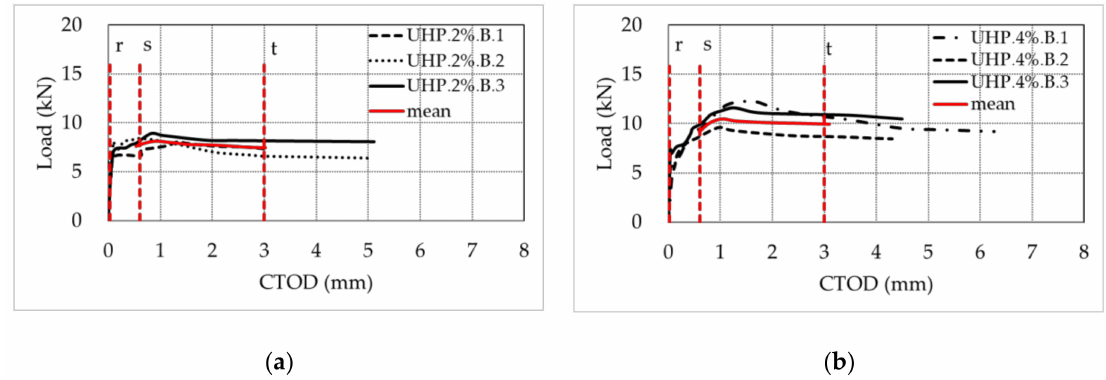
Figure 5. Load-CTOD curves for the notched beam with ( a ) 2% and ( b ) 4% volumetric fractions of polymer fibers. Table 3. Bending test on the concrete reinforced with polymer fibers (UHP): CNR DT 204/ 2006